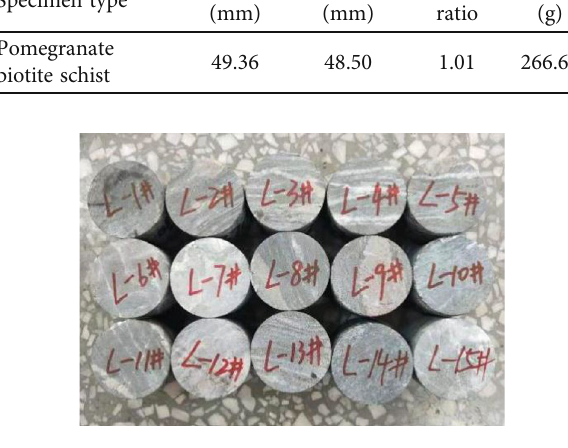
Figure 2: Pomegranate biotite